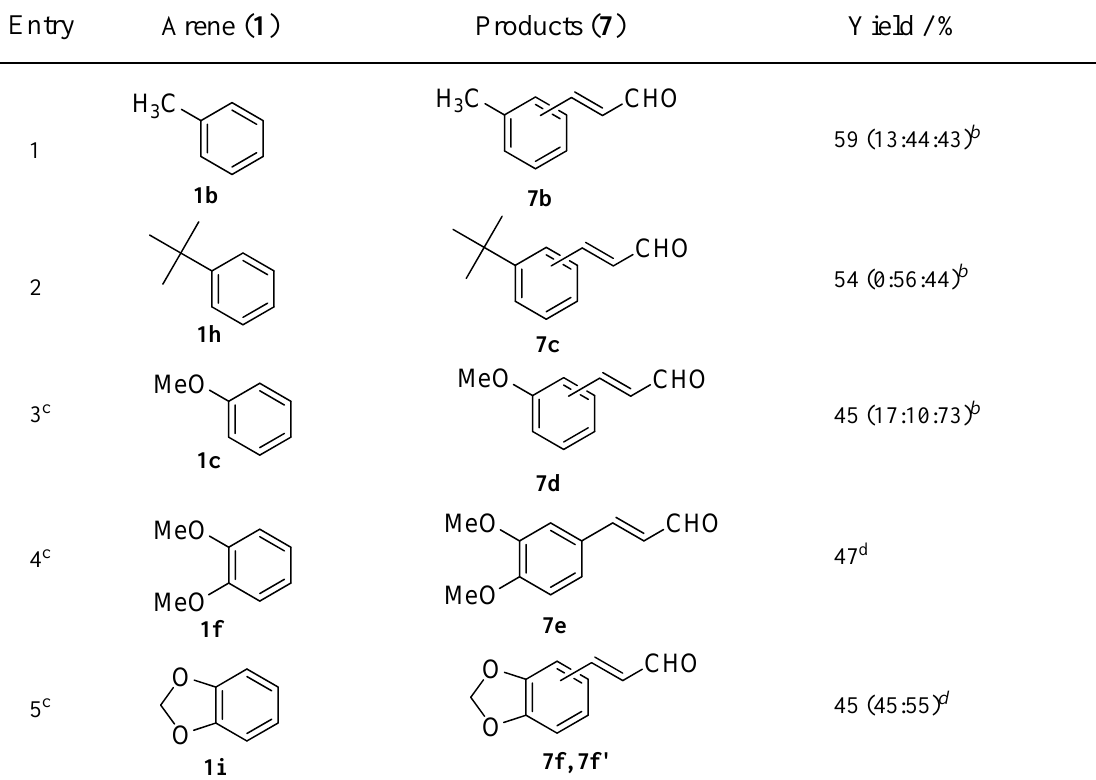
Table 4. Oxidative coupling of arenes 1 with acrolein ( 6a ) catalyzed by Pd(II)/HPMoV.